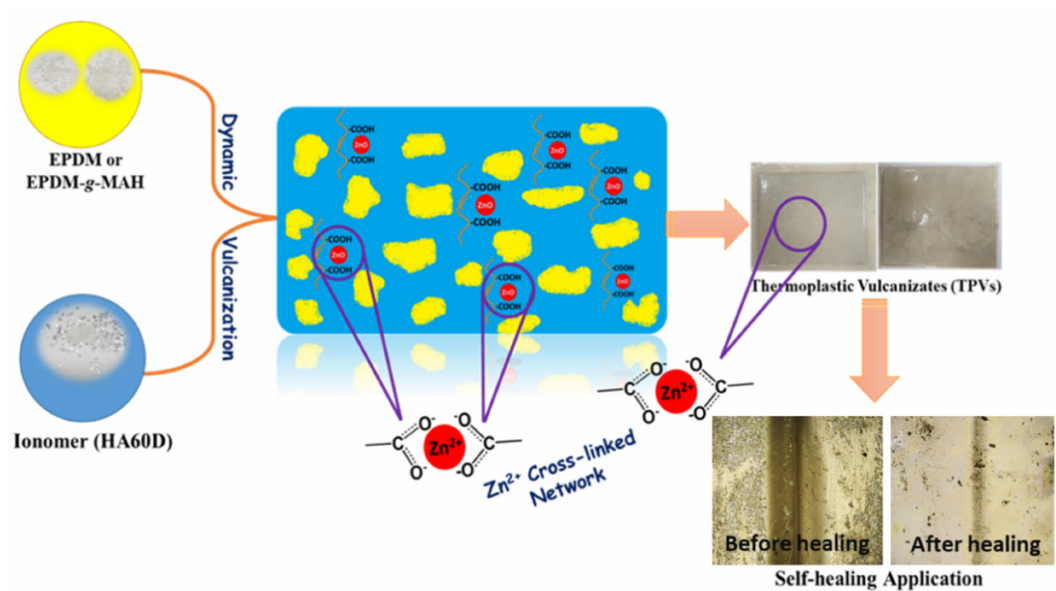
Figure 1. The schematic of the ionic cross-link formation in thermoplastic vulcanizates by Zn 2+ salt-bondings with the carboxyl